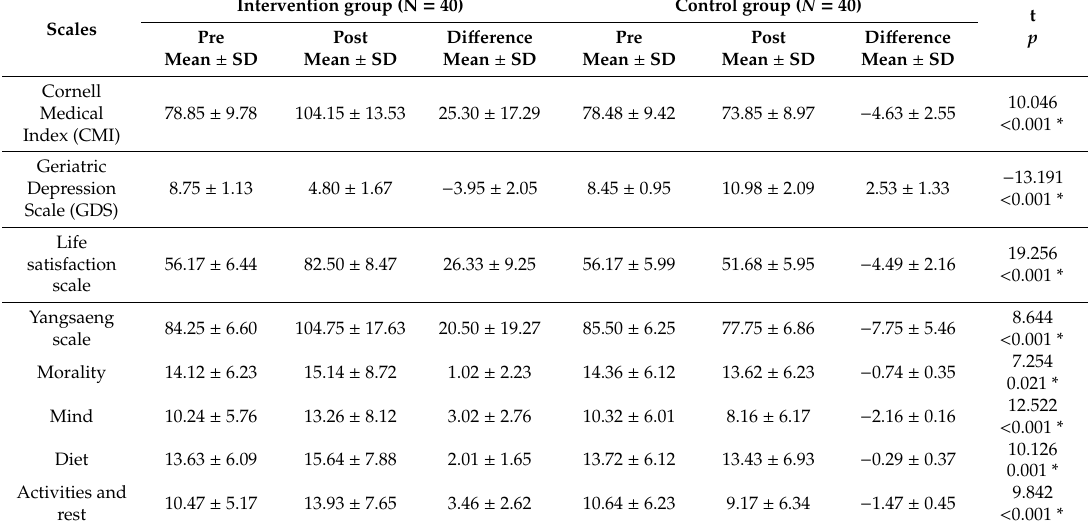
Table 4. E ff ects of Yangsaeng